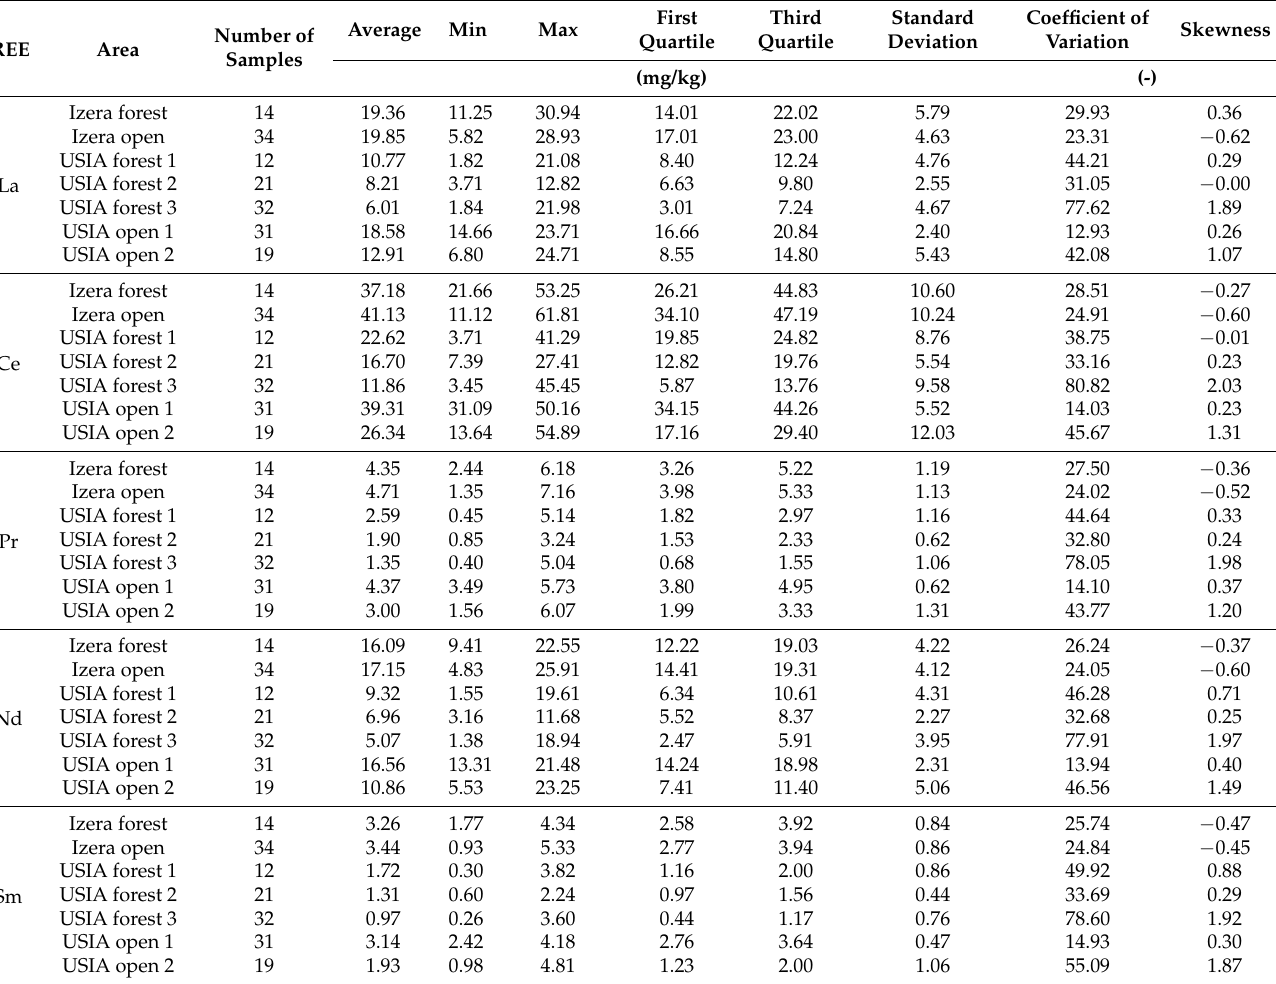
Table 5. Descriptive statistics of concentrations of light REE: La, Ce, Pr, Nd and Sm in soil in study areas, as well as Sc concentration that was used to calculate EF and IG